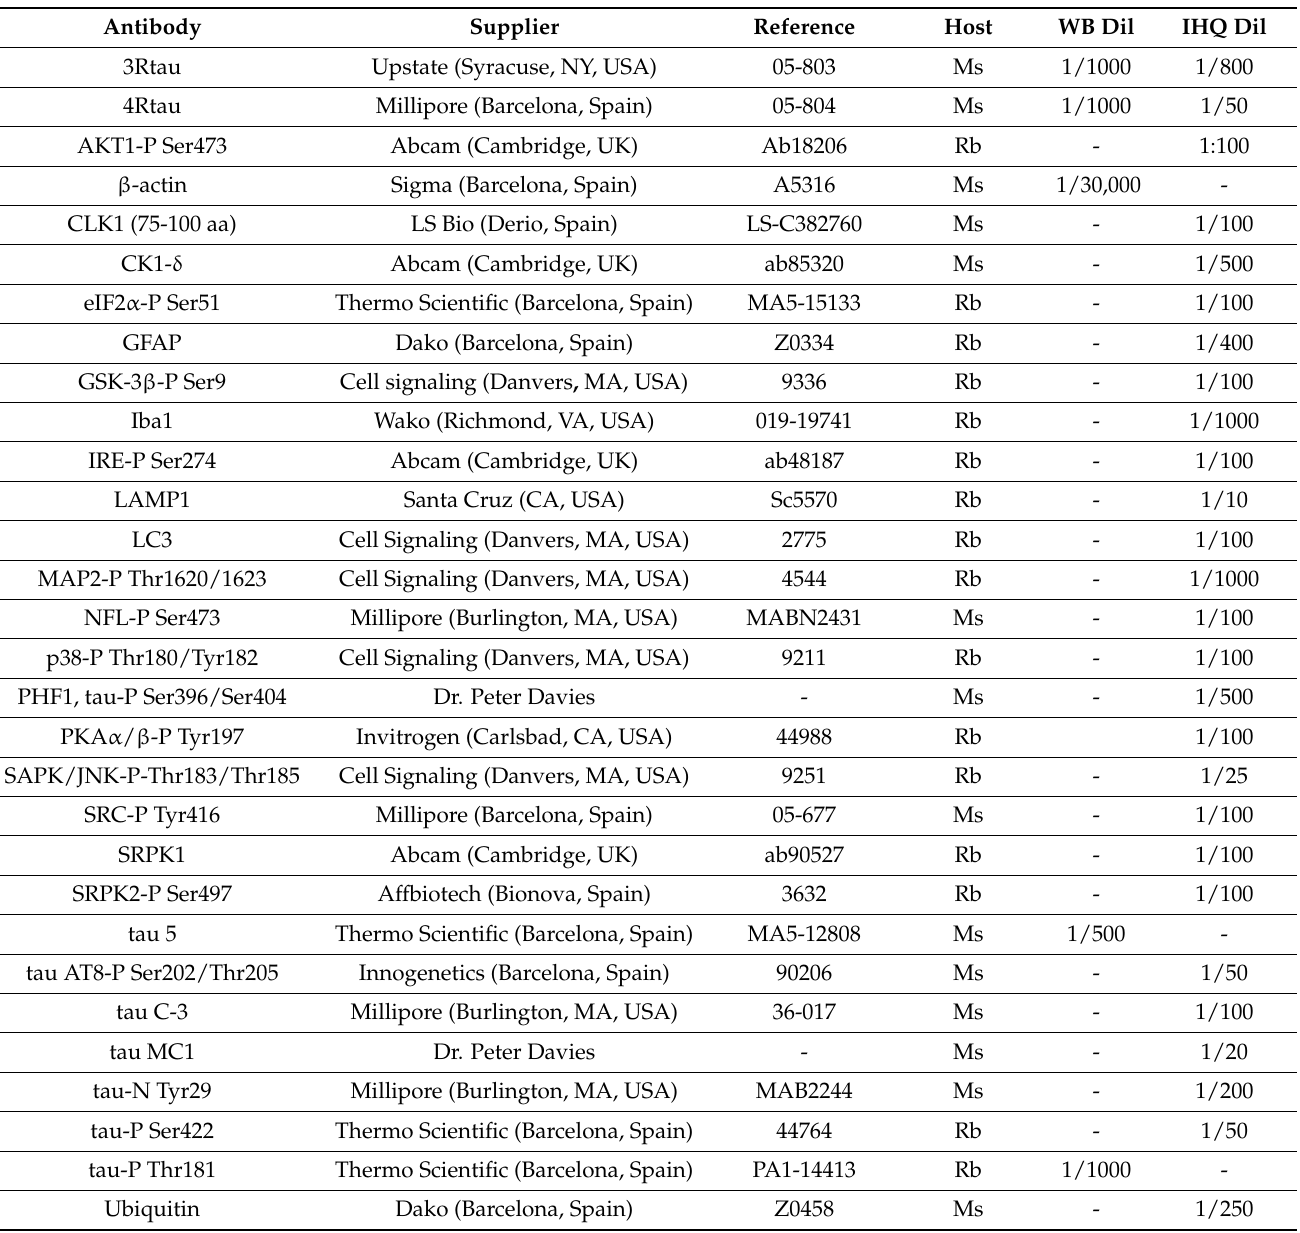
Table 2. List of antibodies used for immunohistochemistry and Western blotting; 3Rtau: tau with three repeats; 4Rtau: tau with four repeats; AKT1: serine/threonine-protein kinase AKT1; β -actin; CK1- δ : casein kinase δ ; eIF2 α : eukaryotic initiation factor 2 α ; GSK β : glycogen synthase kinase 3 β ; IRE1: inositol-requiring enzyme 1 α ; LAMP1: lysosomal-associated membrane protein 3; LC3: microtubule-associated protein 1A/1B-light chain 3; MAP2: microtubule-associated protein 2; NFL: neurofilament light molecular weight; p38: p38-kinase; PHF1: anti-paired helical filament 1; PKA α / β : cAMP-dependent protein kinase A; SAPK/JNK: stress-activated protein kinase/Jun amino-terminal kinase; SRC: tyrosine-protein kinase SRC; Tau 100; Tau 5: monoclonal recognizing total tau protein; Tau AT8; Tau C3: tau truncated at aspartic acid 421; Tau MC1: conformation tau; Tau-N: nitrated tau; Tau-P phosphorylated tau. The phosphorylation or nitration of the protein at the specific site is indicated in every case. WB dil: Western blotting dilution; IHQ dil: immunohistochemistry